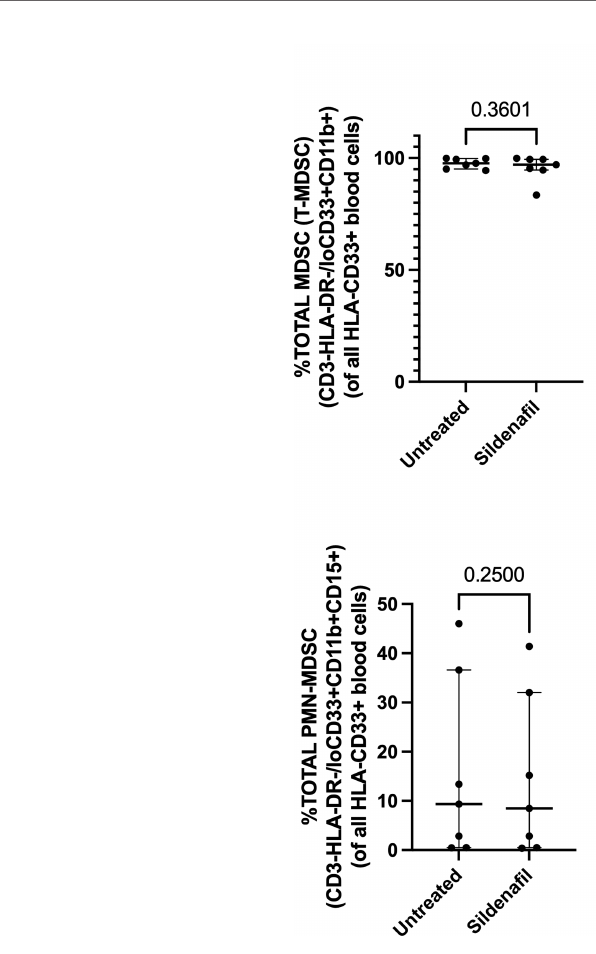
FIGURE 2 | Effect of Sildena fi l on the frequency of (A) Total MDSC, (B) M-MDSC, (C) PMN-MDSC, (D) Control Monocytes, gated as a frequency of MACS isolated HLA-CD33+ or HLA+ cells, from in vitro cultures of MDSC (HLA-CD33+ cells) and Control Monocytes isolated from PBMC of individuals with active TB disease (n = 7). Plots show individual TB patient data. D ’ Agostino and Pearson normality Test. Paired t test (parametric data) and Wilcoxon matched pairs signed rank test (non- parametric data). Median with interquartile range indicated on plots. P<0.05 was considered signi fi